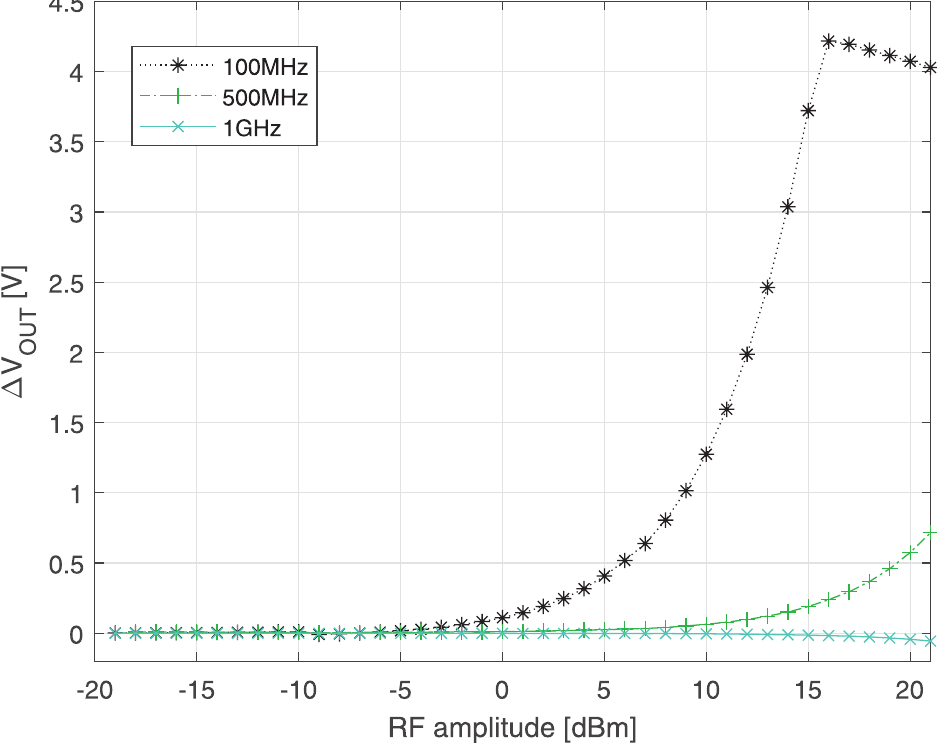
Figure 16. DPI on VDD immunity measurements ( | ∆ V OUT | vs. RF power amplitude) for different